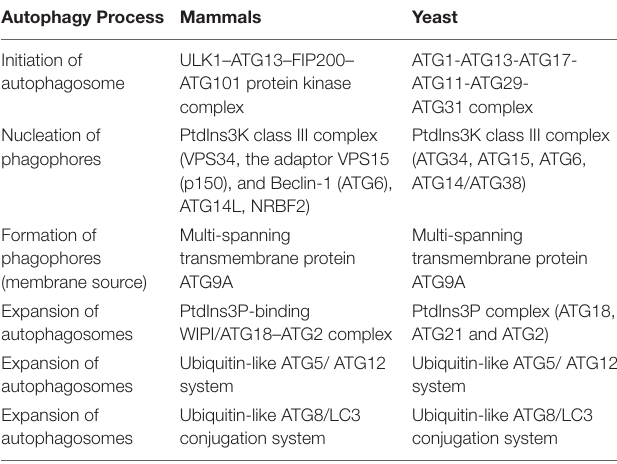
TABLE 1 | Function of ATGs in different steps during autophagosome biogenesis. Autophagy Process